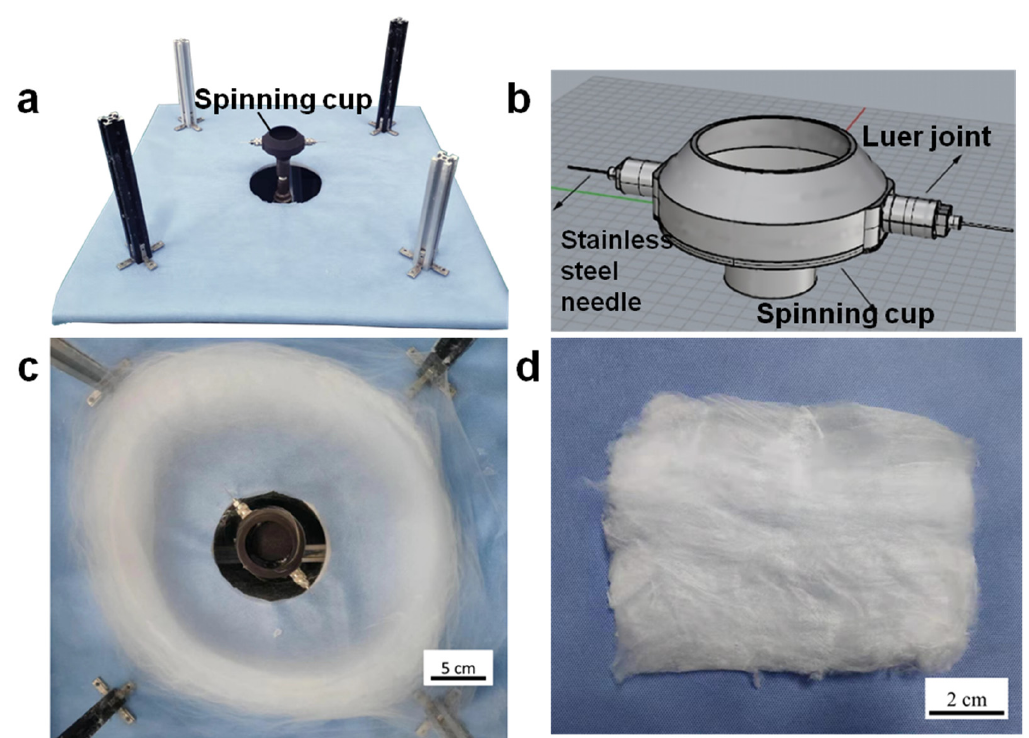
Figure 2. Digital image of the main part of ECS setup ( a ) including a spinning cup with ( b ) two nozzles as the spinneret; ( c ) Digital images of the ECS setup with fibers inside and ( d ) the produced PVA fibers.